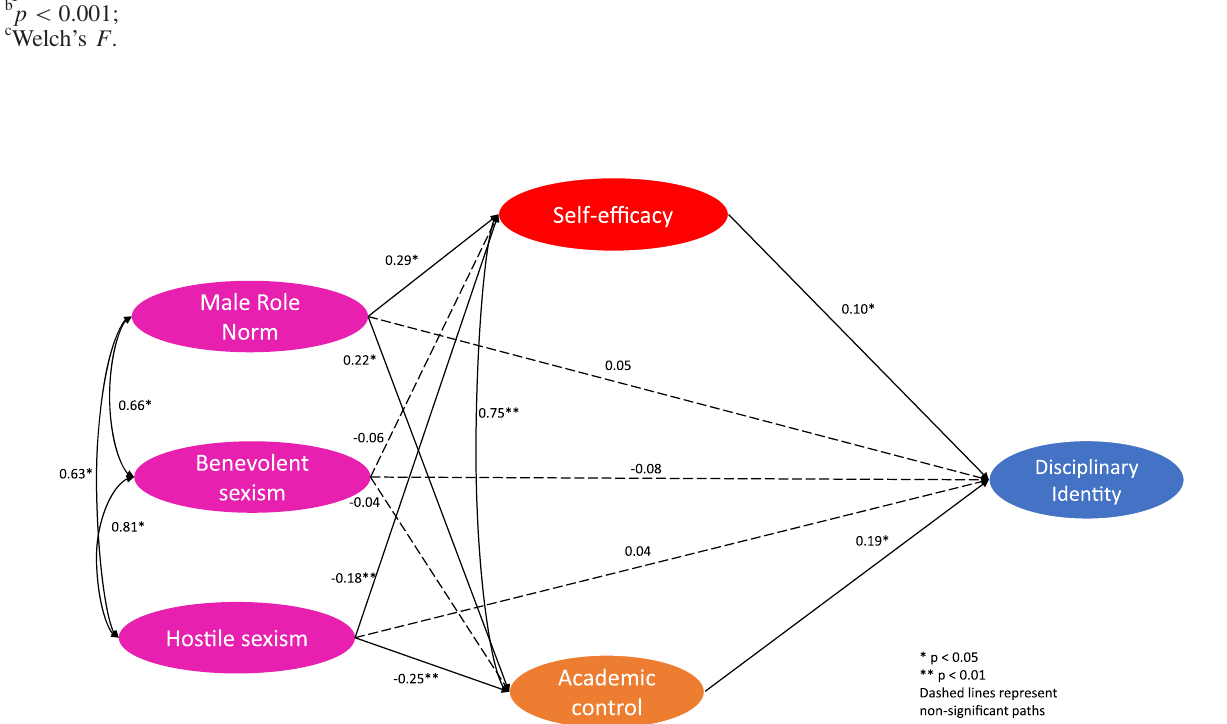
FIG. 2. Path analysis for the whole sample showing the relationships between gender stereotypes, self-efficacy, perceived academic control, and disciplinary